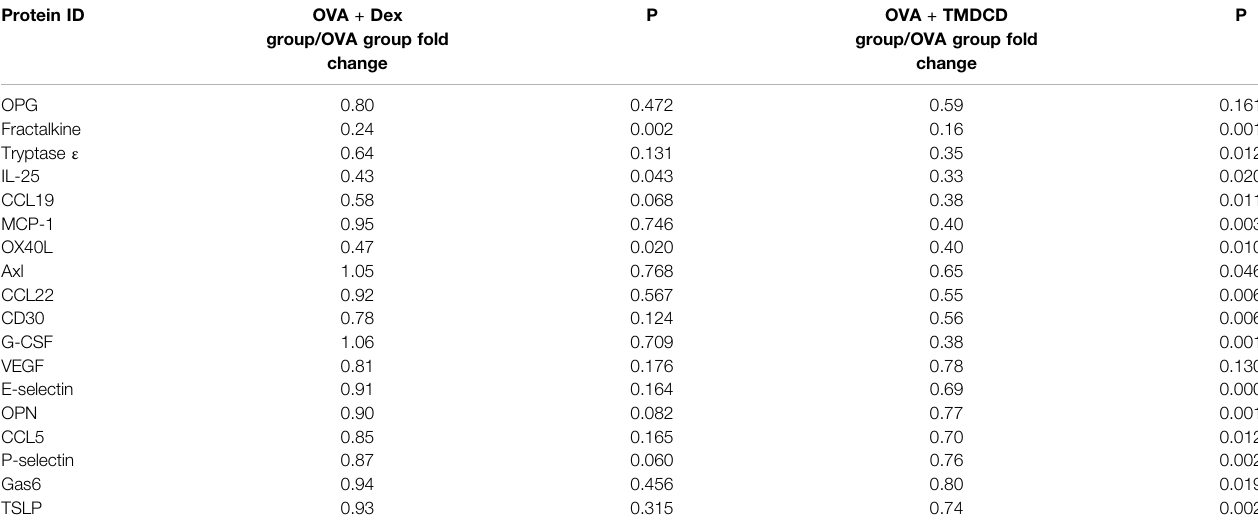
TABLE 3 | Effect of TMDCD on relative expression of differential expressed proteins in serum of OVA-challenged mice (n (cid:2) 4-5 mice/group). Protein